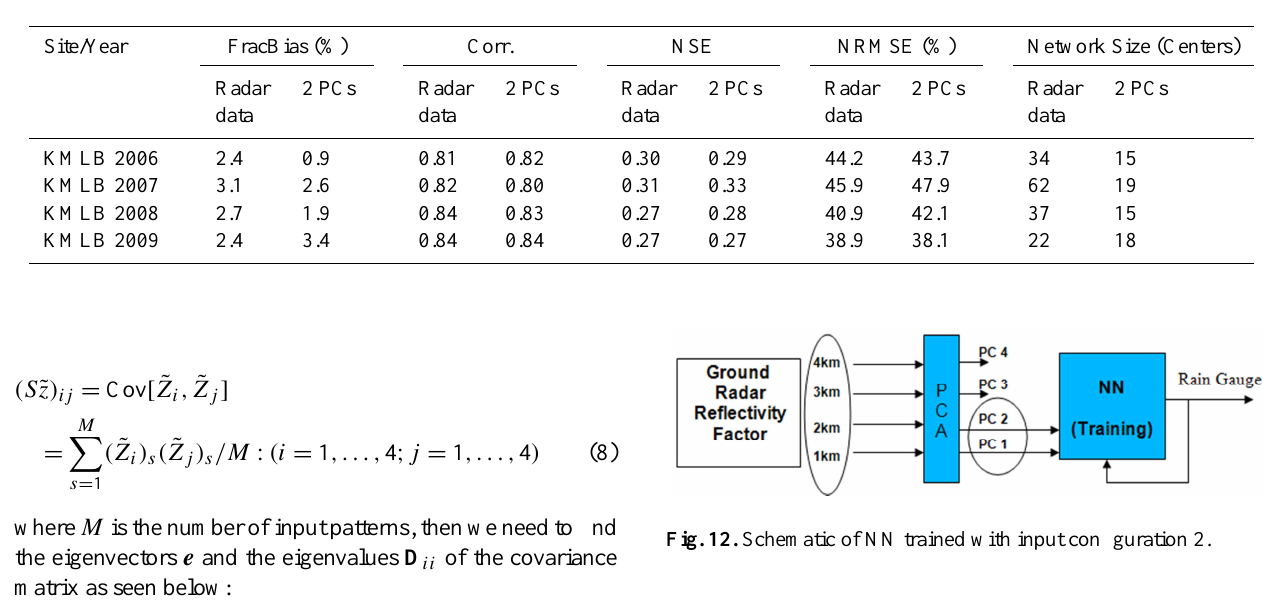
time and the network size is to see the effect of the size of the input data and to see how feasible the network can be in order to be applied in real